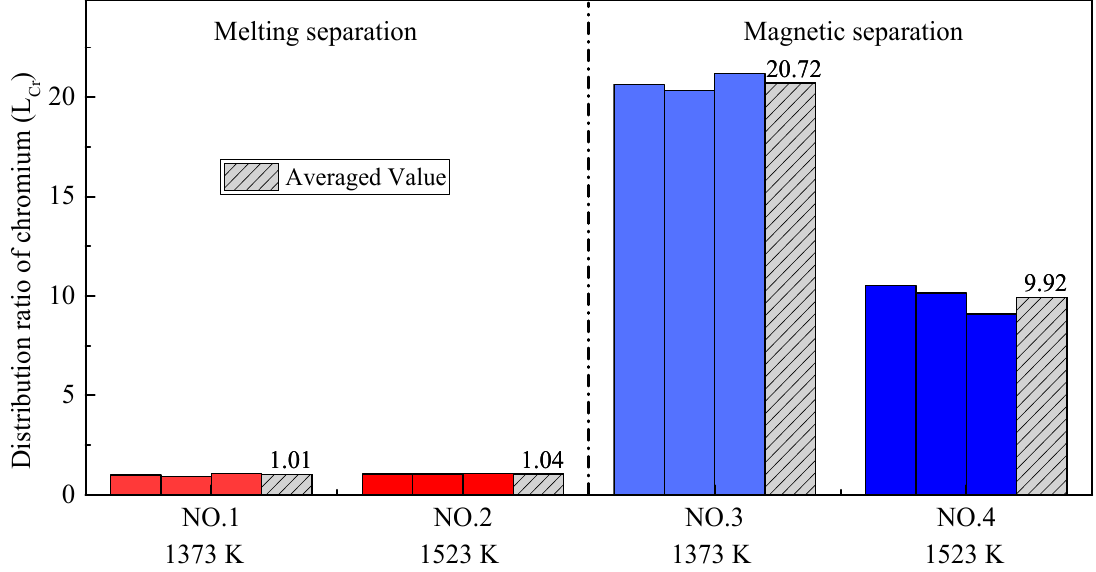
Figure 8. Distribution ratio of chromium with different pre-reduction temperatures and different separation processes.